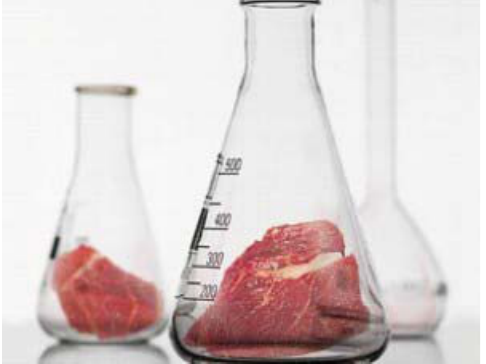
Figure 1. First associations: a steak in an Erlenmeyer